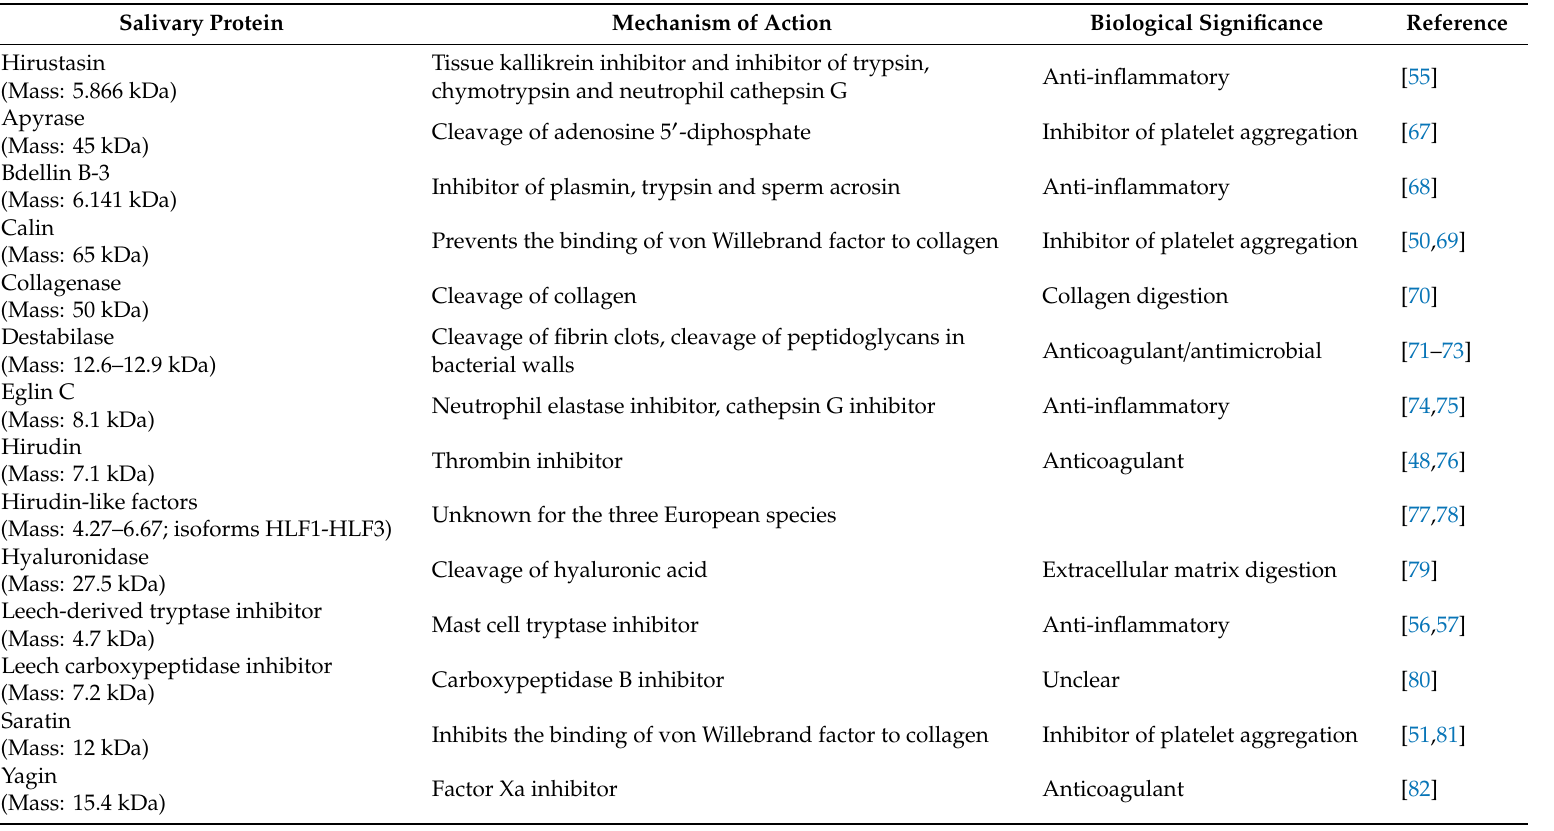
Table 1. Leech salivary proteins from H. medicinalis, H. verbana or H. orientalis. Isoforms of individual proteins are not shown. Salivary